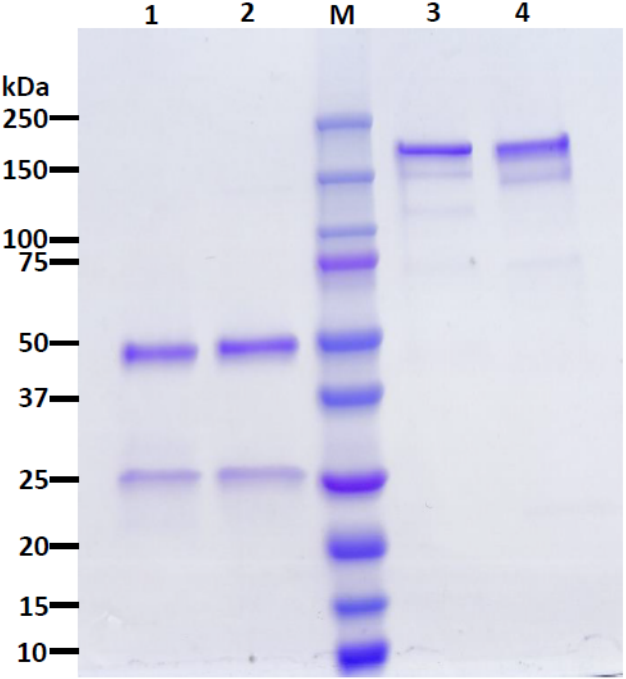
Figure 1. Purification of CA1 from Nicotiana benthamiana leaves. CA1 purified by Protein A affinity chromatography was subjected to SDS-PAGE under reducing (Lane 1) or non-reducing (Lane 3) conditions on a 4–20% gradient polyacrylamide gel, and the total protein content was stained with Coomassie Brilliant Blue. Approximately 2.5 µg of IgG was loaded in each lane. Lanes 1 and 3, plant-made CA1; Lanes 2 and 4, a mammalian cell-produced anti-West Nile virus E protein (E16) IgG control; M, molecular weight ladder. One representative gel of several experiments is shown.